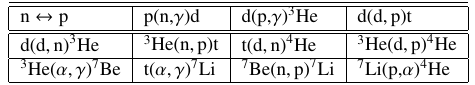
Table 1: Most relevant BBN reactions.